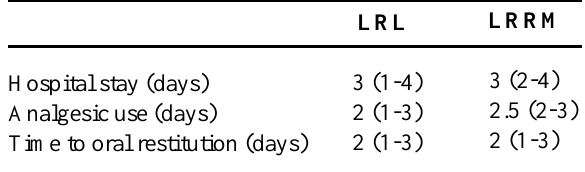
Table 3 – Postoperative data from LRL and